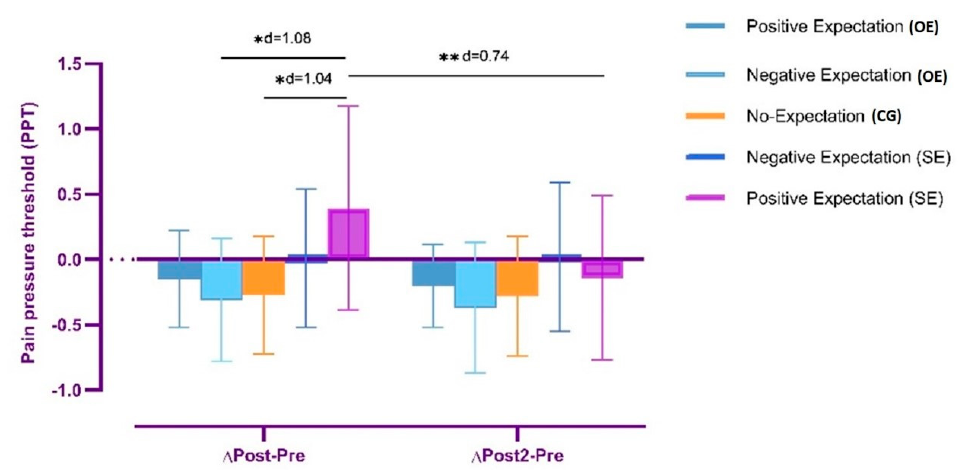
Figure 3. Differences in proximal pain pressure threshold between groups and time–group interaction, * p < 0.05, ** p < 0.001.